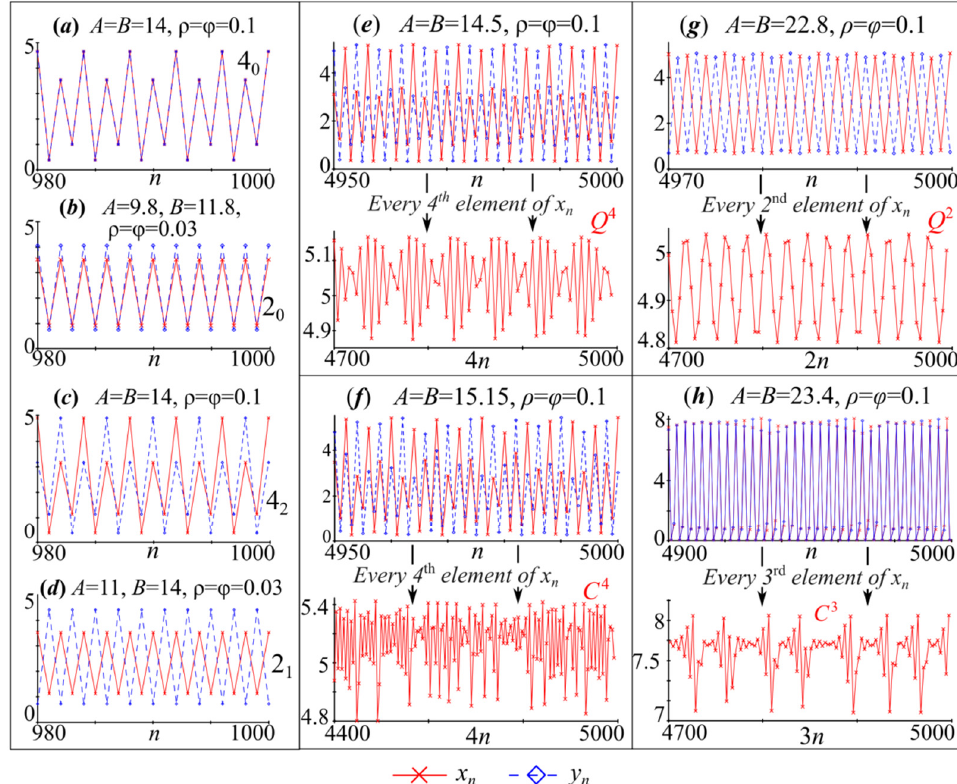
Figure 7. Examples of regular ( a – d ) and irregular ( e – h ) dynamics of system (4). 2 0 and 4 0 is in-phase oscillations x n and y n with period 2 and 4, 2 1 and 4 2 is out-of-phase oscillations. Q and C are quasiperiodic and chaotic out-phase dynamics.